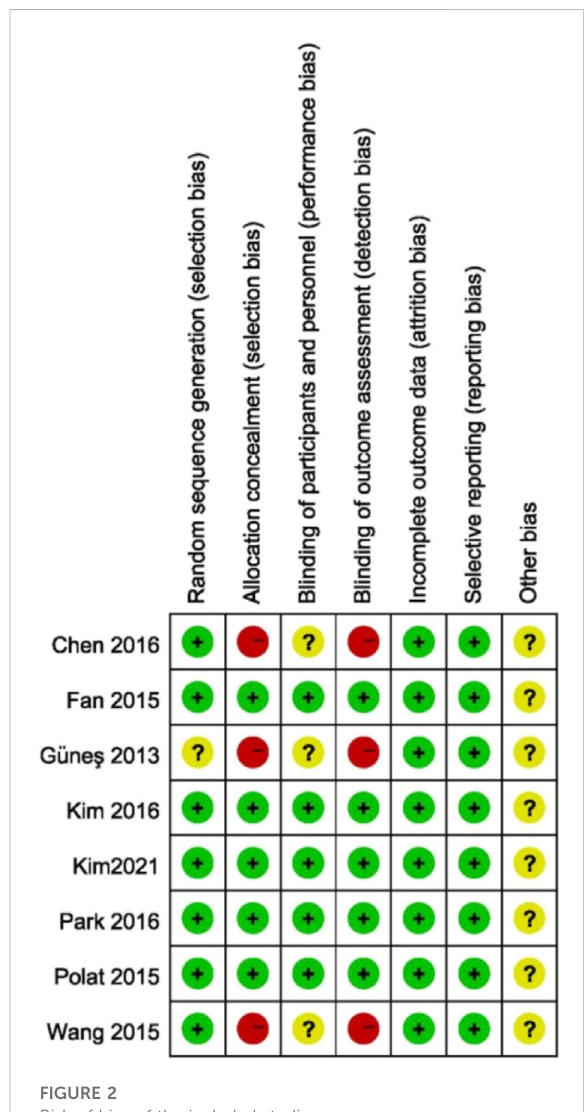
FIGURE 2 Risk of bias of the included